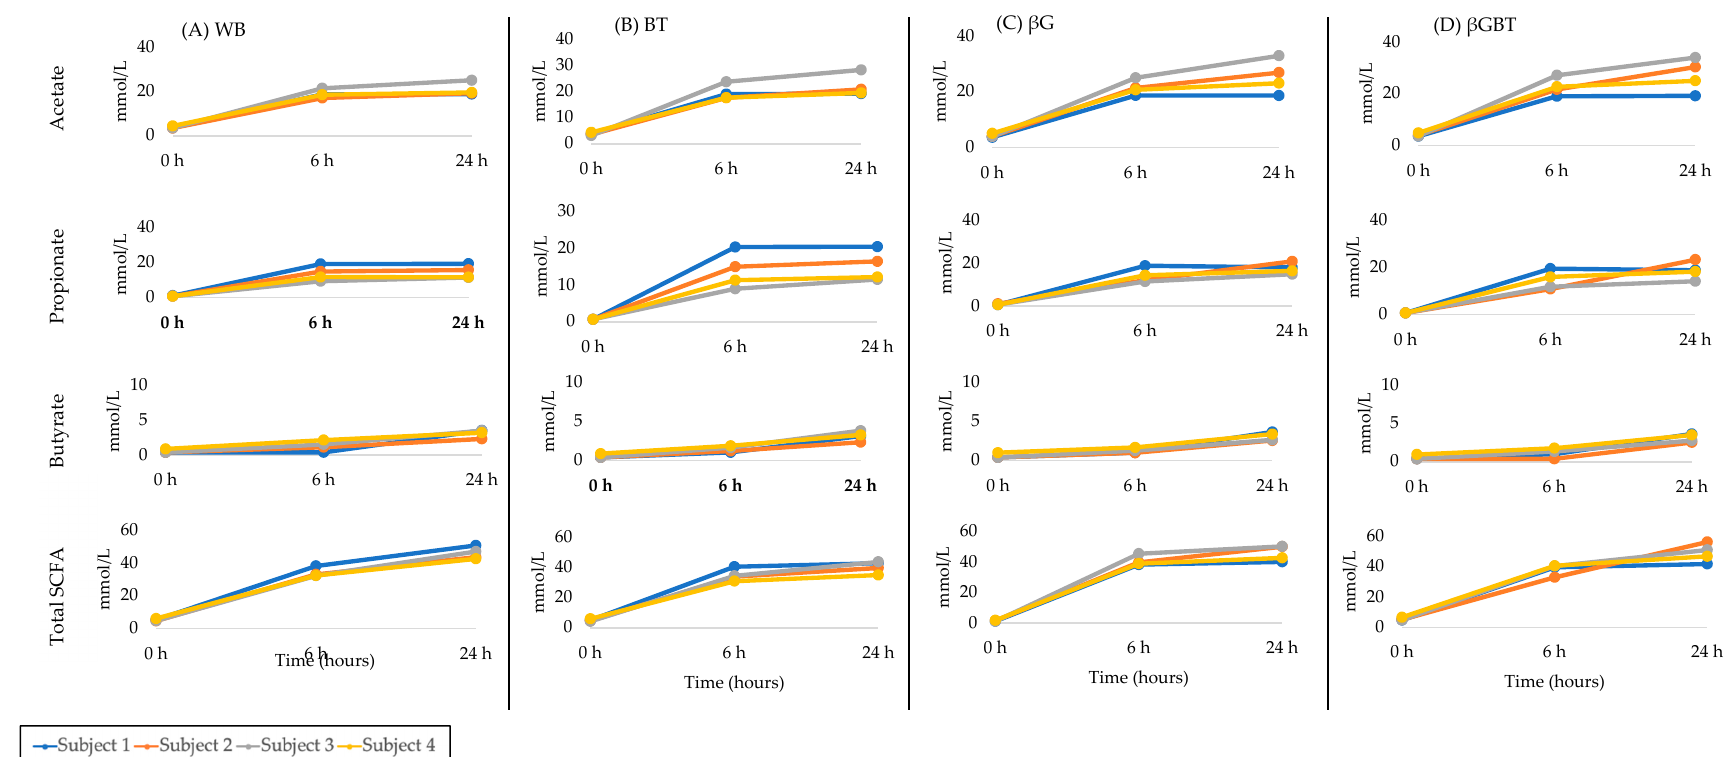
Figure 3. Absolute SCFA production in in vitro fermentations from individual Donors ( n = 4) at 0, 6 and 24 h. ( A ) WB, white bread; ( B ) BT, black tea bread; ( C ) β G, beta glucan bread; ( D ) β GBT, beta glucan with black tea bread.